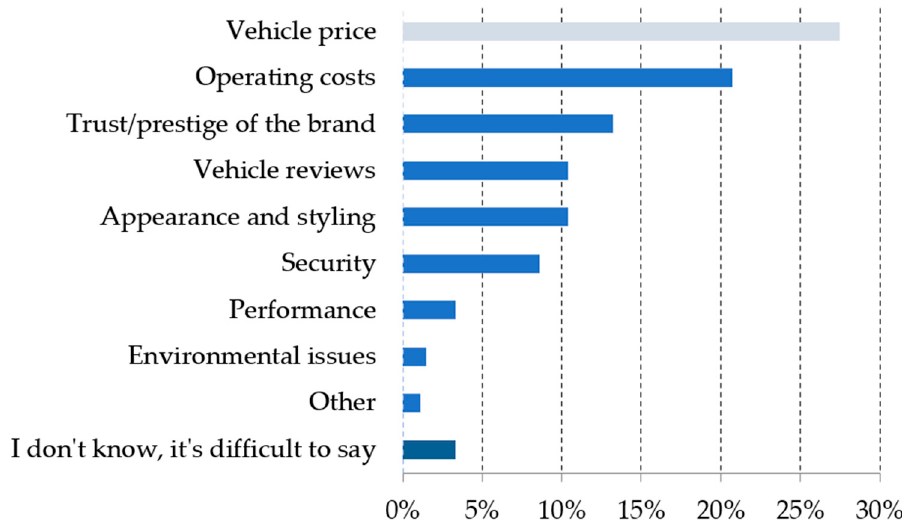
Figure 12. Answers to the question: “Which factor mostly affected your decision when choosing the car you most often use?” stated in the course of the “New Mobility Barometer 2020/2021” study